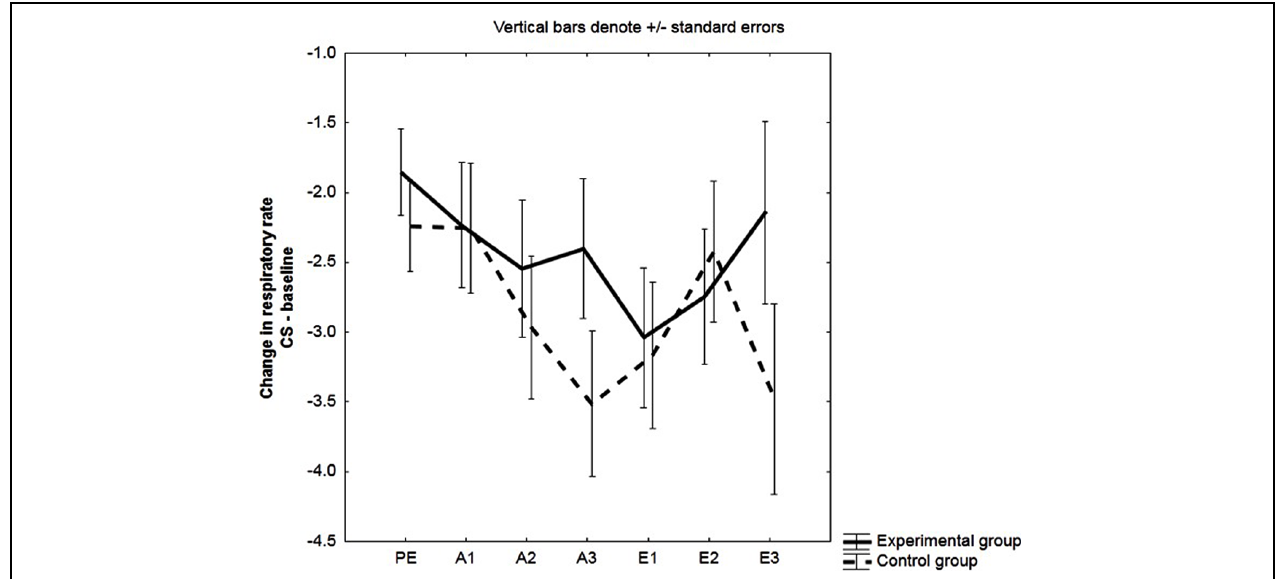
FIGURE 3 | Change in respiratory rate (RR). Mean changes in RR (in cycles per minute, cpm) during the CS relative to baseline (CS minus baseline) for the experimental and the control group. Respiratory responses were averaged across three pre-exposure trials (PE), two acquisition trials (A1, A2, A3) and two extinction trials (E1, E2, E3).